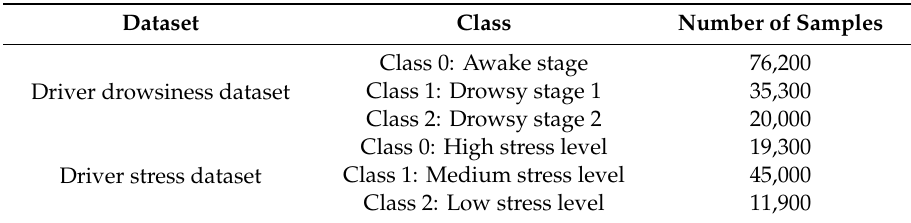
Table 1. Definition of classes and number of samples in driver drowsiness and stress dataset.